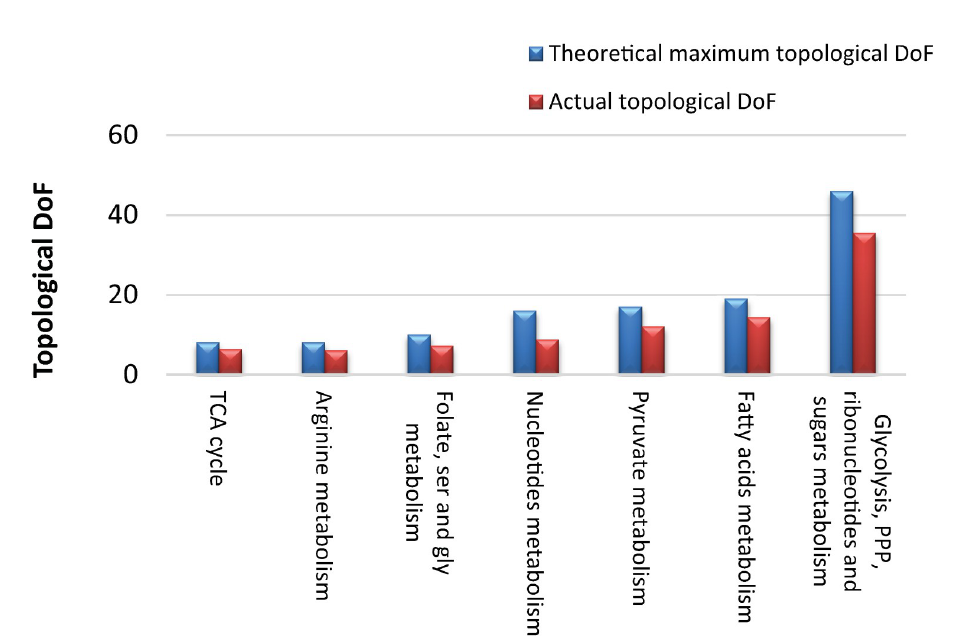
Fig 5. Theoretical maximum and actual “topological” DoF of the seven larger modules of the E . coli iJO1366 reconstruction.